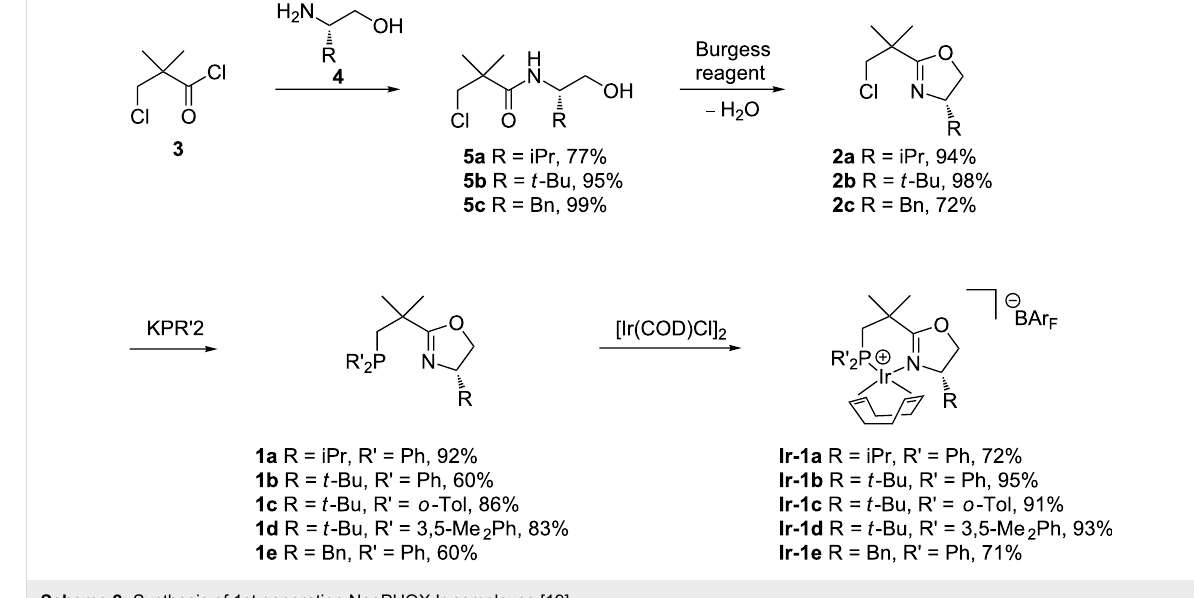
Scheme 2: Synthesis of 1st generation NeoPHOX Ir-complexes [19].